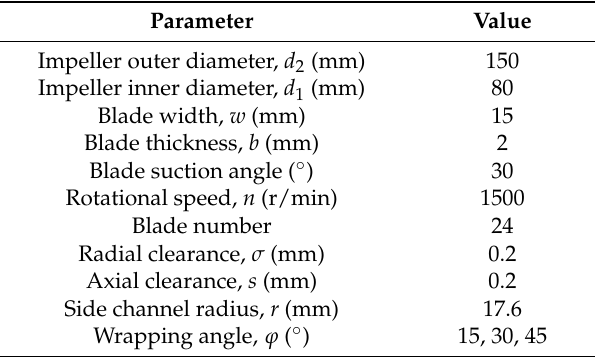
Table 1. Main parameters of pump